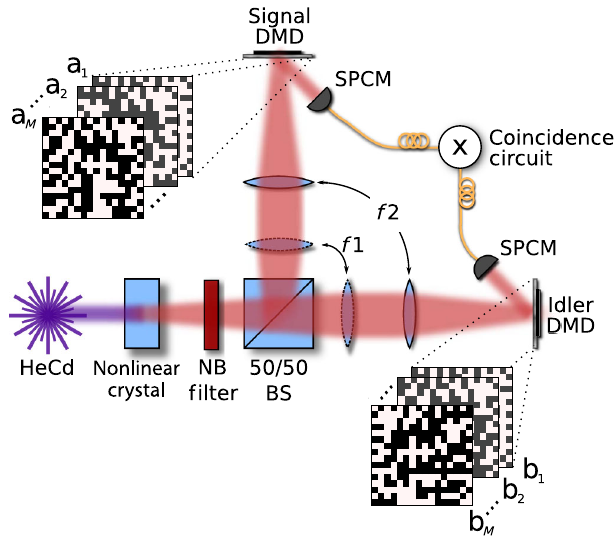
FIG. 1. Experimental setup. Photons generated via SPDC pass through a narrow-band (NB) filter and are split into signal and idler modes by a 50 = 50 beam splitter (BS). For position corre- lations, lenses f 1 ¼ 125 mm and f 2 ¼ 500 mm form a 4 f imaging system with the crystal and DMDs placed in the object and image planes, respectively. For momentum correlations, f 1 is removed and the DMD is placed in the focal plane of f 2 ¼ 88 : 3 mm . Photons striking DMD ‘‘on’’ pixels are directed to large-area SPCMs. Photon arrivals are then correlated by a coincidence